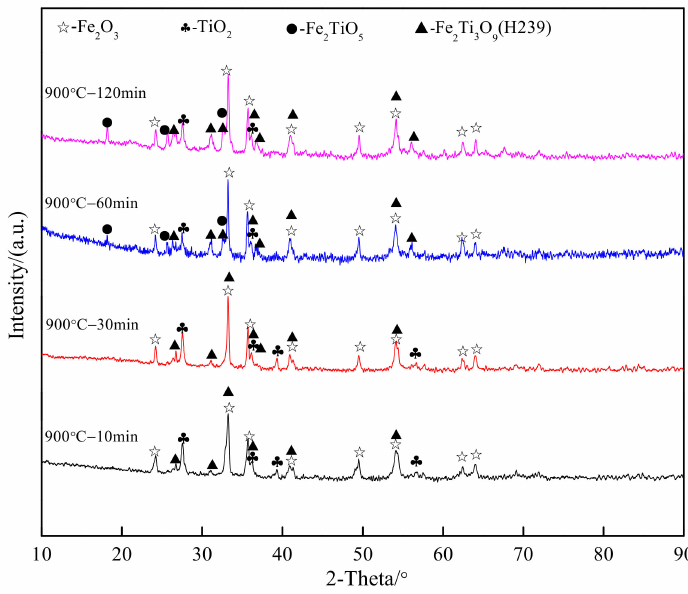
Figure 4. Chemical transformations of ilmenite A0 with the increase in roasting